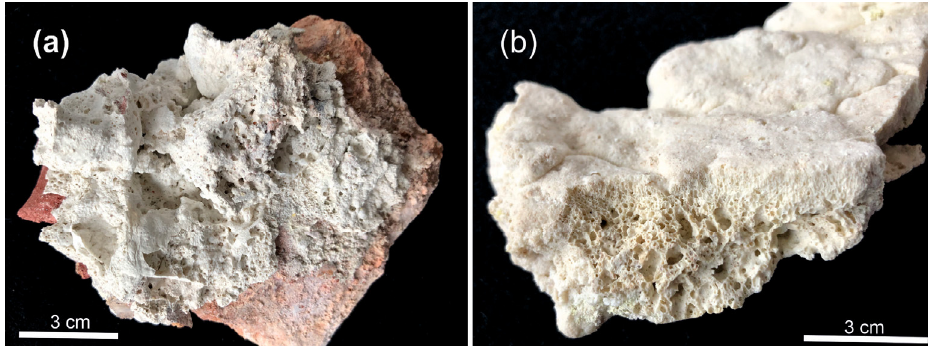
Figure 4. Millosevichite from Rydułtowy. ( a ) Monomineral accumulation covered red clinker fragment. ( b ) Vesicular structure typical for high temperature sulfates.